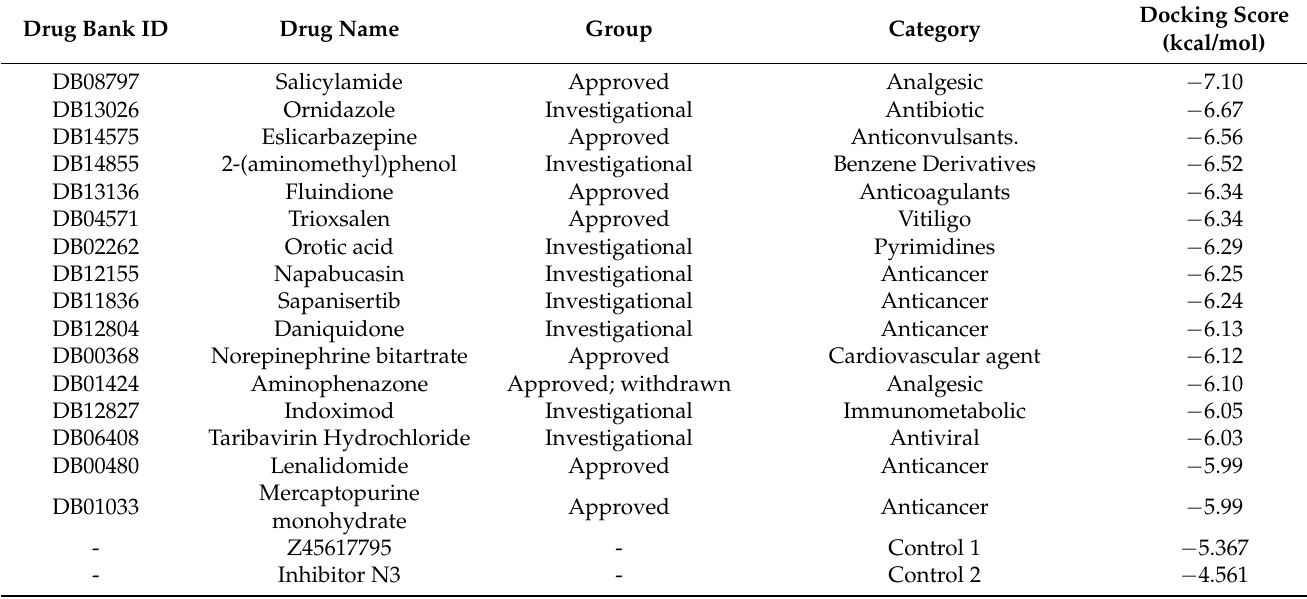
Table 2. Docking score of approved and investigational drugs.